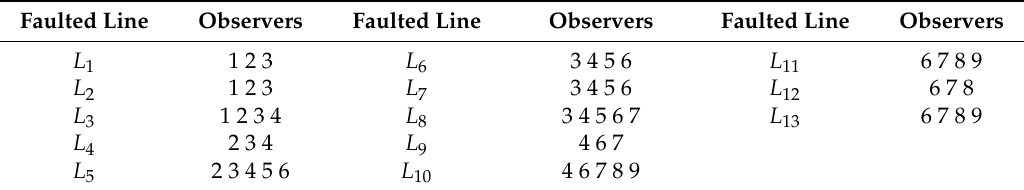
Table 1. Fewest observers for selecting fault